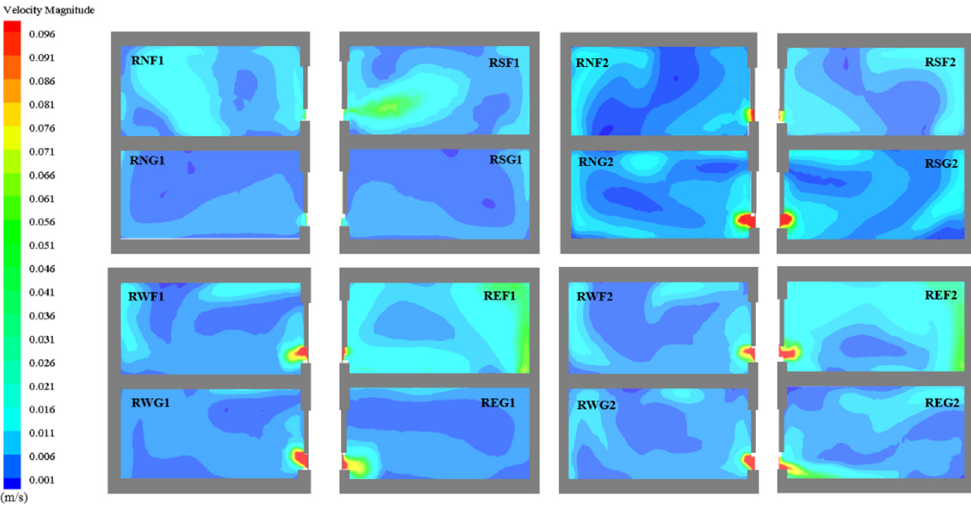
Figure 28. Contours of the wind speed in each room for the baseline courtyard model with four small trees.